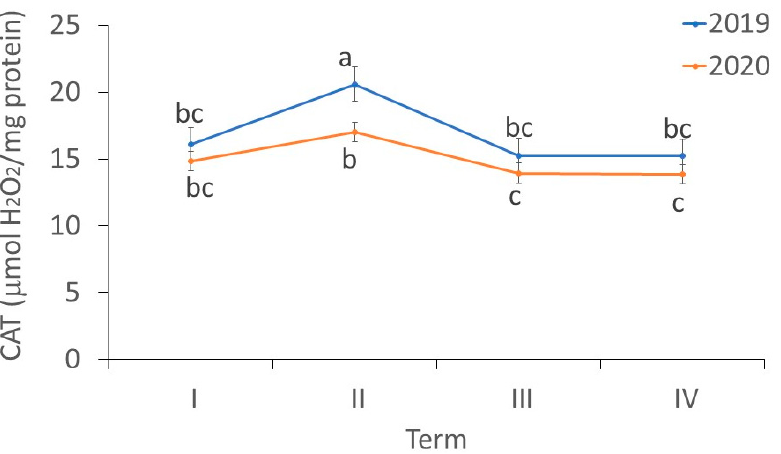
Figure 8. Changes in the CAT activity ( µ mol H 2 O 2 /mg protein) in A. fabae fundatrigeniae during feeding on V. opulus (means ± SD; n = 4). Different letters denote significant differences (one–way ANOVA; Tukey’s test; p < 0.05).